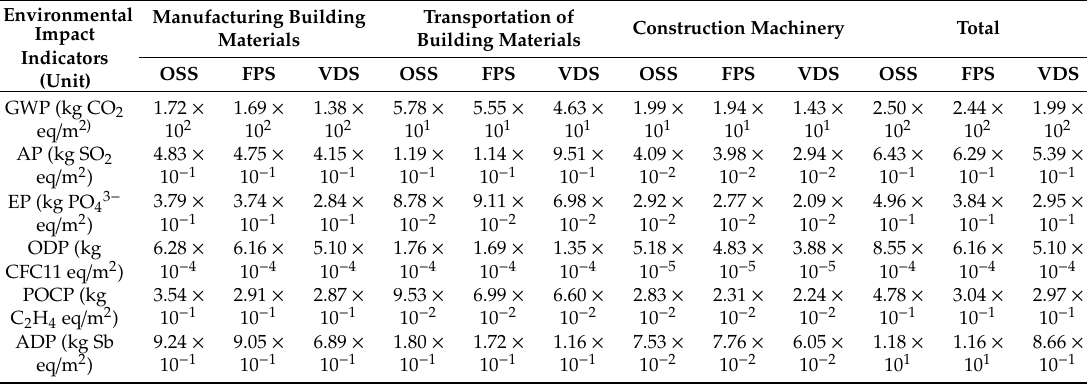
Table 4. Total environmental impacts of flat plate